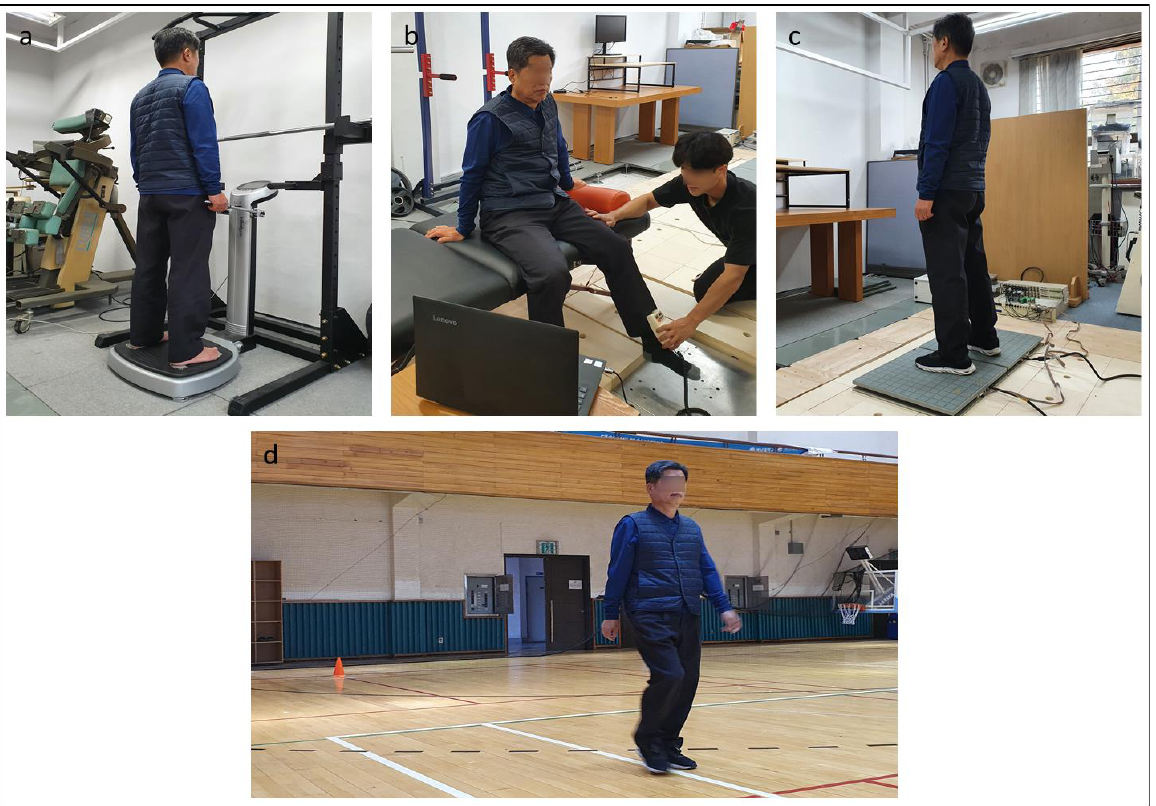
Figure 1. Example of experimental protocol: ( a ) body composition measurement; ( b ) lower extremity muscle strength test; ( c ) static balance test; ( d ) the 6-minute walk test.